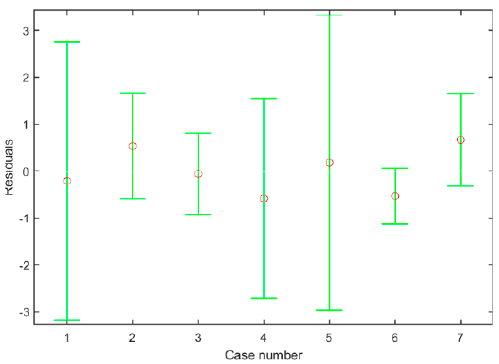
Figure 9. The plot of residual case order. Table 3. Results of the multi-variable regression model error